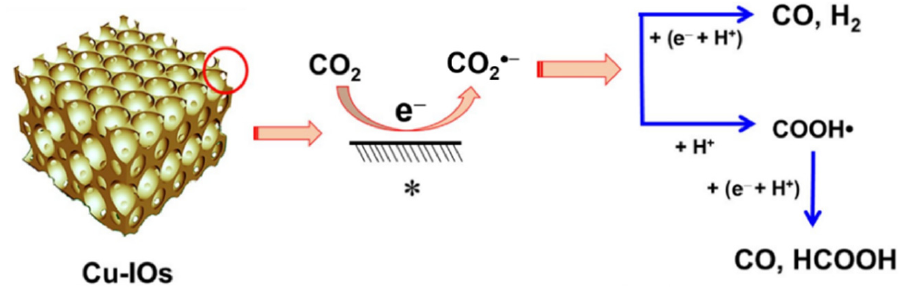
Figure 17. Proposed mechanism for CO 2 reduction to CO and HCOOH on Cu 2 O-derived Cu-IOs (The symbol “*” represents the surface.) [116].